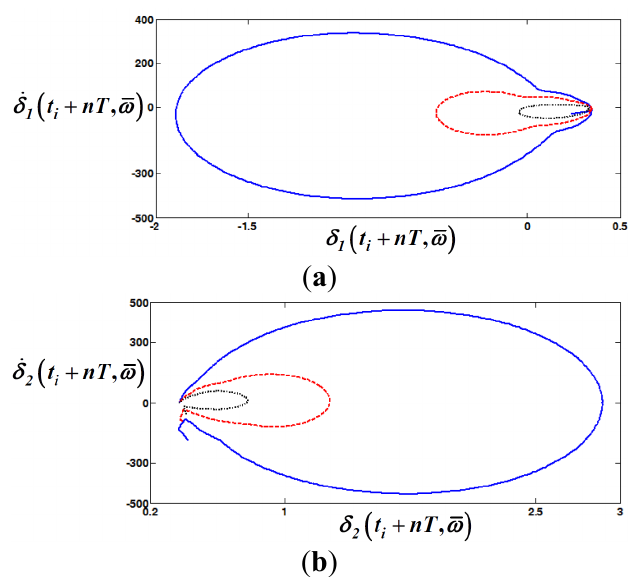
Figure 10. Comparison of Poincaré maps under different excitation conditions: ( a ) Poincaré map of